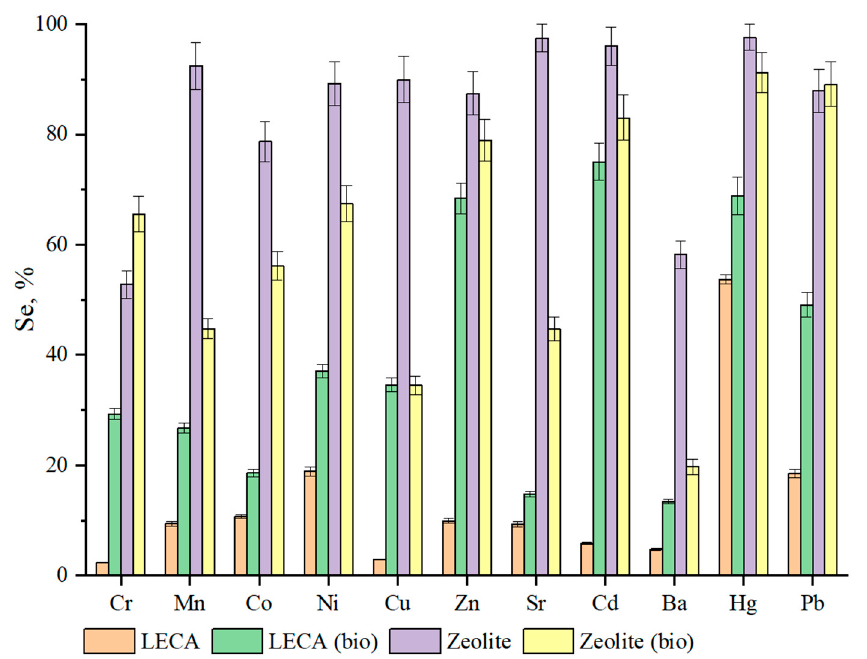
Figure 2. Metal immobilization on untreated and biofilm-coated materials.